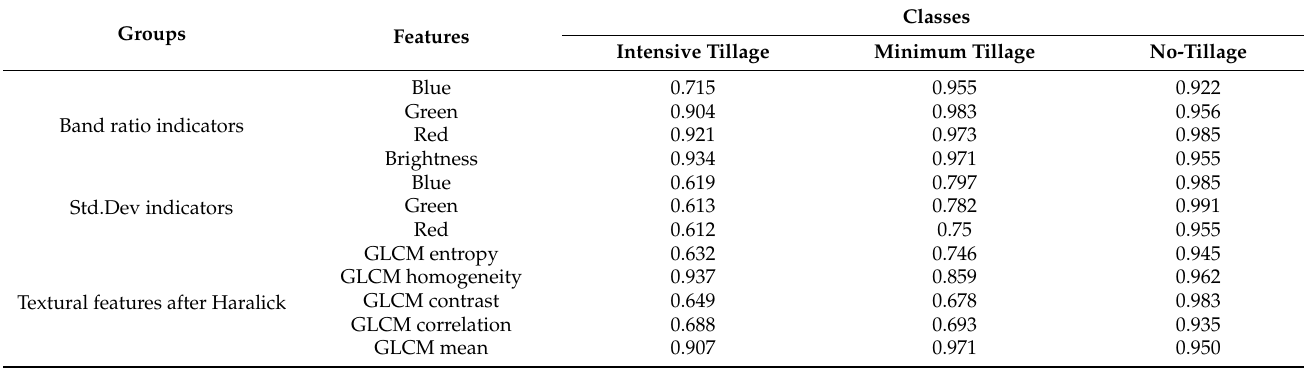
Table 3. Fuzzy numbers for different features about three classes of tillage intensity for the digital UAV image.